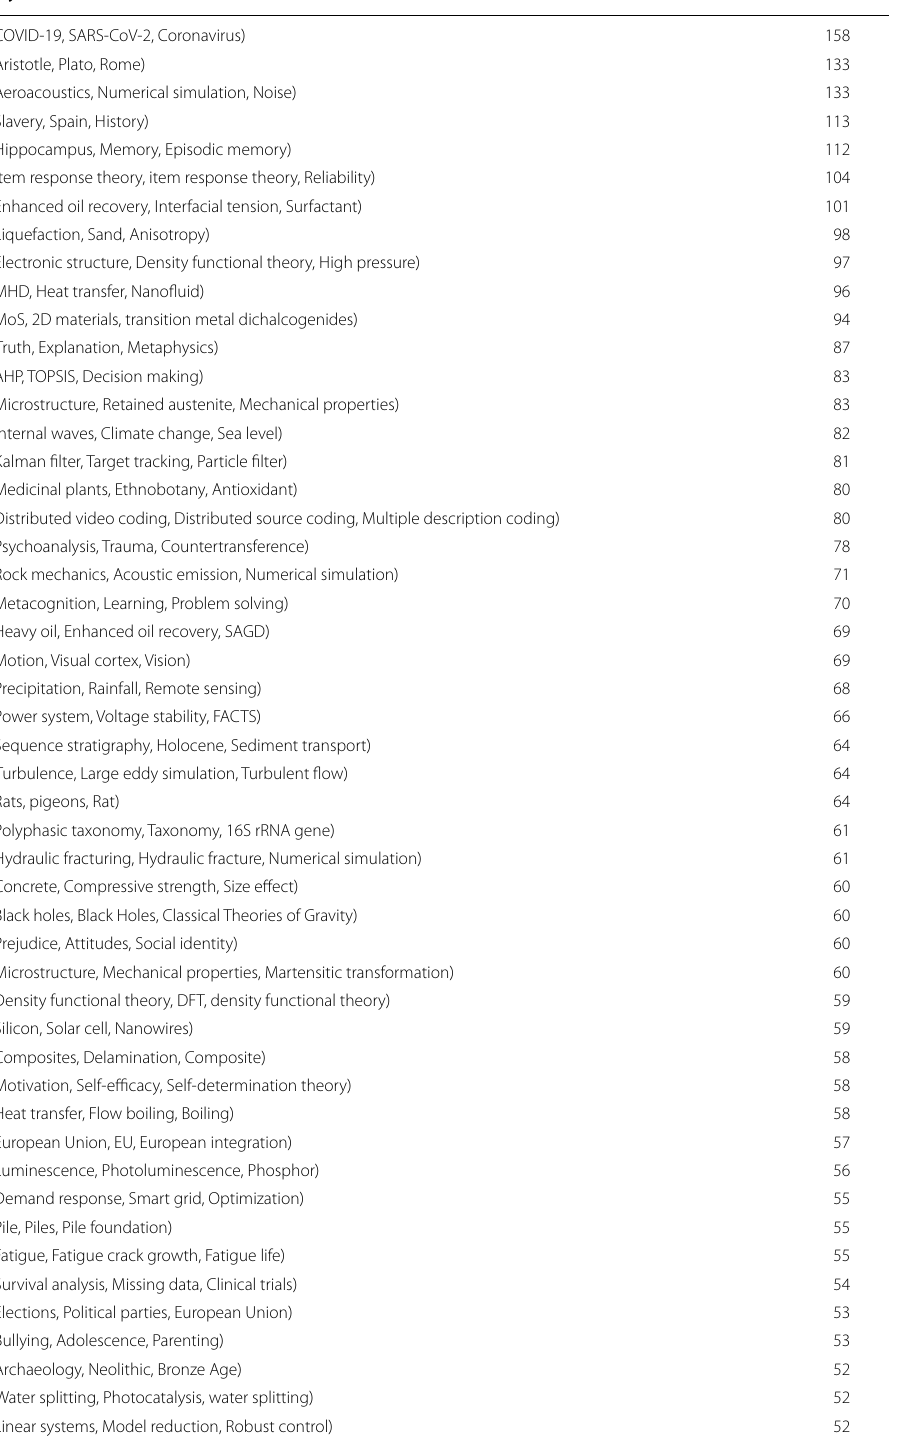
Table 14 Most frequent category including SB (Category labelled by 2020)